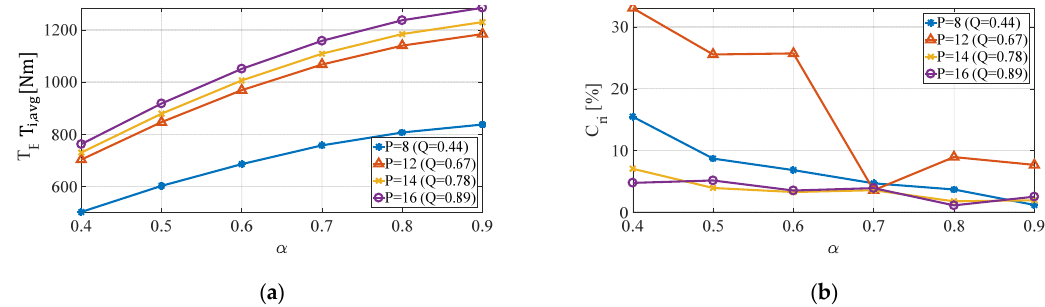
Figure 11. ( a ) Average ideal torque T i , avg and ( b ) its ripple factor C ri for di ff erent pole spans α